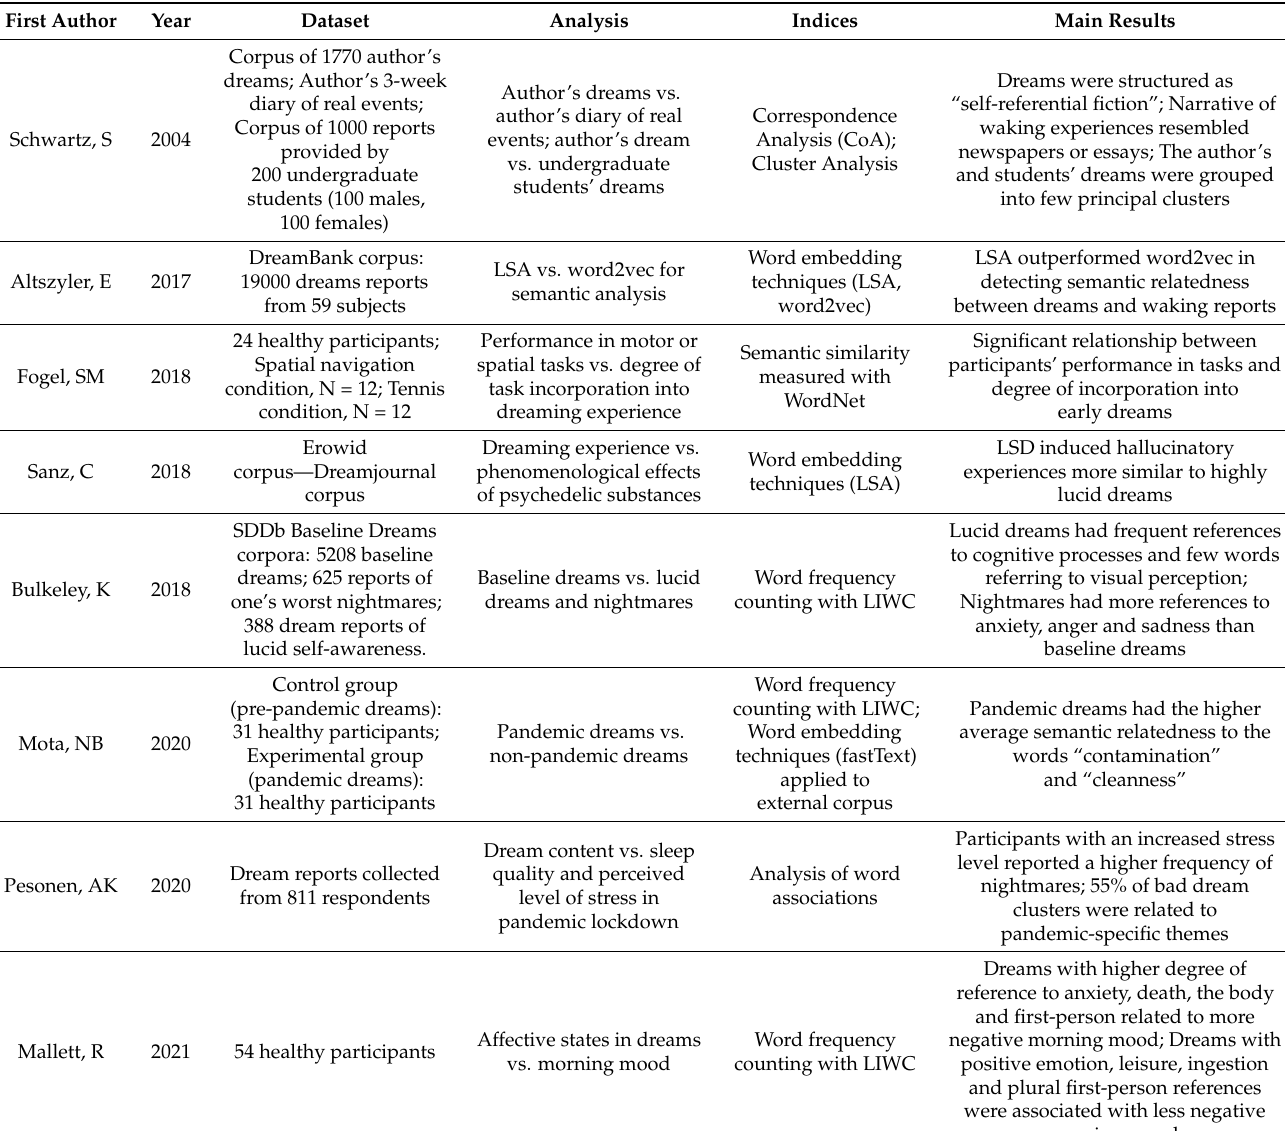
Table 3. Overview of studies using dictionary-based methods or distributional semantics approaches (described in Section